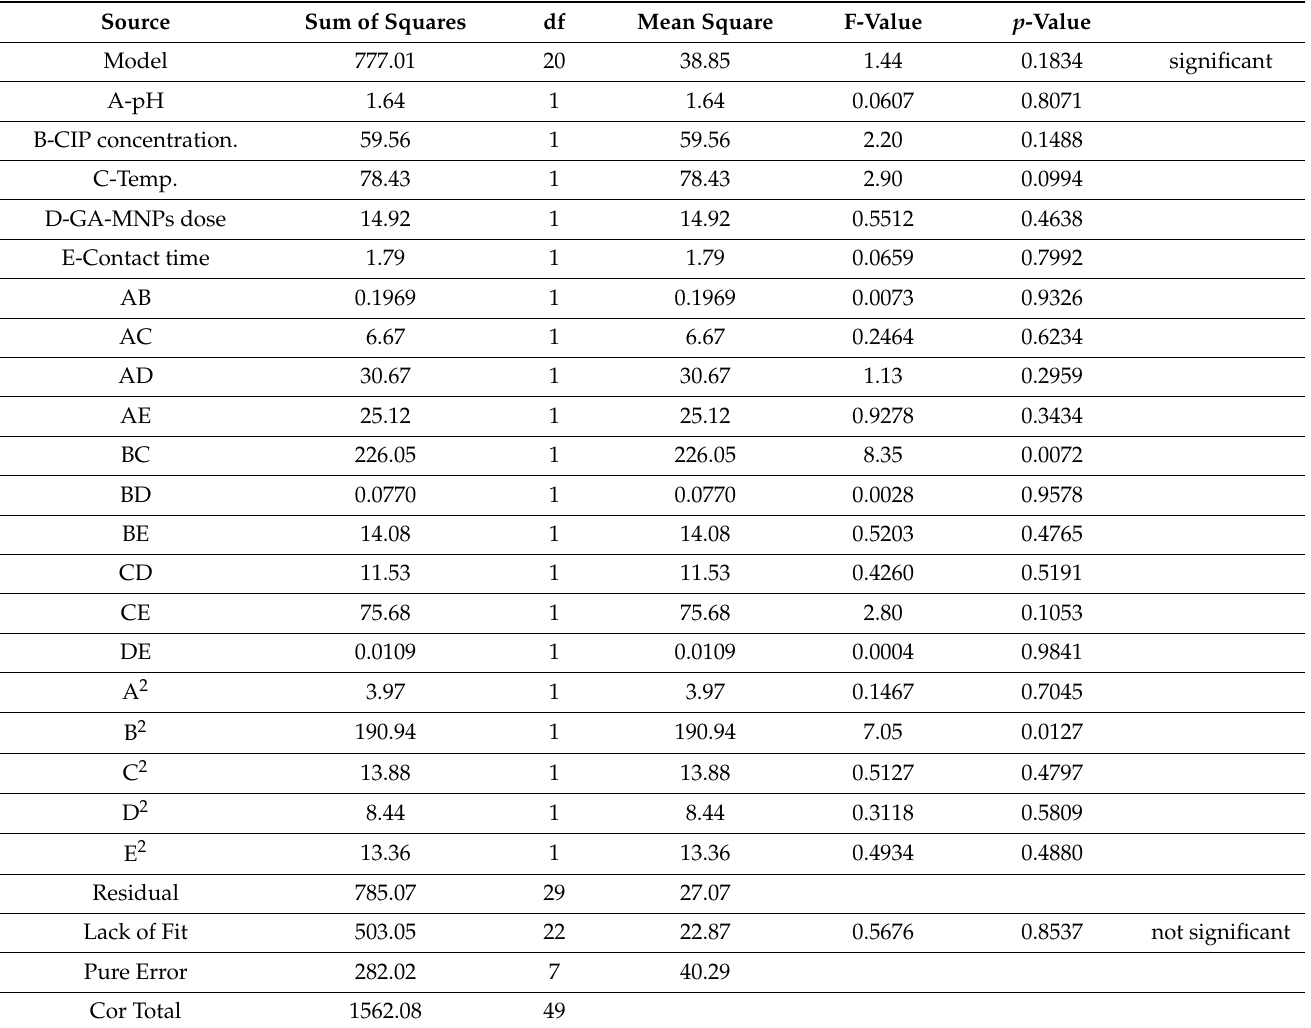
Table 4. ANOVA by RSM for CIP removal